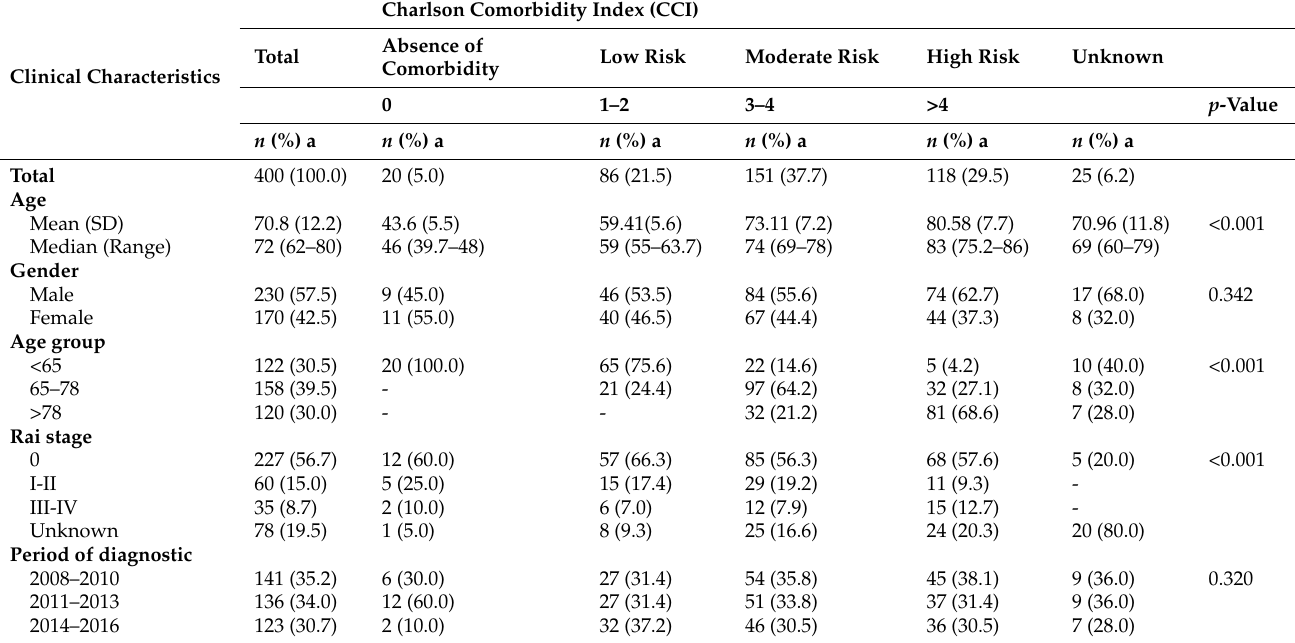
Table 1. Distribution of baseline characteristics of chronic lymphocytic leukemia patients according to the Charlson comorbidity index